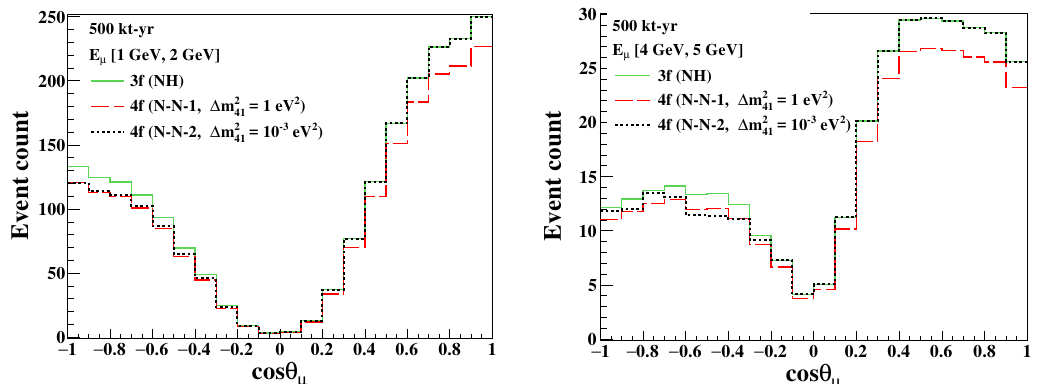
Figure 4 . (cid:22) (cid:0) event distributions for E (cid:22) 2 [1 ; 2] GeV (left panel) and E (cid:22) 2 [4 ; 5] GeV (right panel) in the three-(cid:13)avor case, and in scenarios with sterile neutrinos of two candidate (cid:1) m 2 corresponding to the N-N-1 and N-N-2 con(cid:12)gurations. We take j U e 4 j 2 = 0 : 025, j U (cid:22) 4 j 2 = 0 : 05, and j U (cid:28) 4 j 2 = 0. The information on hadron energy is not used. the energy dependence is mild. We have explicitly checked that the features for (cid:1) m 2 10 (cid:0) 5 eV 2 (N-N-3 con(cid:12)guration) are the same as those for N-N-2 con(cid:12)guration. Figure 4 shows the event distribution as a function of reconstructed cos (cid:18) energy bins. For (cid:1) m 2 = 1 eV 2 (N-N-1 con(cid:12)guration), the fractional loss in the number of 41 events is observed to be almost uniform throughout the cos (cid:18) & 0) as compared to the three-(cid:13)avour scenario, while for the upward-going events (cos (cid:18) (cid:22) . 0), a clear loss of events is observed. This is due to the fact that at such low (cos (cid:18) (cid:22) sterile (cid:13)avor. We have explicitly checked that the features for (cid:1) m 2